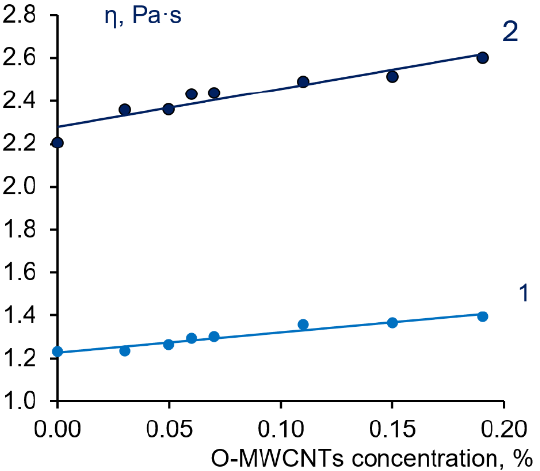
Figure 5. The dependence of dynamic viscosity ( η ) of colloid systems containing 15 wt.% PPSU–15 wt.% PEG 20,000–0.5 wt.% PVP K-30-0-0.19 wt.% O-MWCNTs in NMP on O-MWCNTs concentration at 40 ◦ C (1) and 60 ◦ C